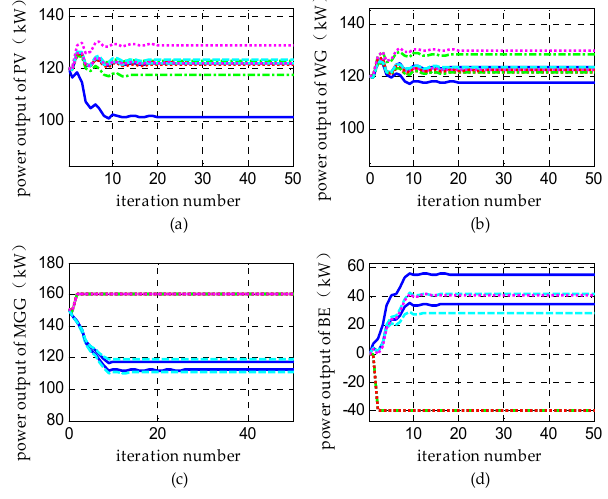
Figure 10. Dispatch results in Scenario D . ( a ) Power output of PV; ( b ) Power output of WG; ( c ) Power output of MGG; and ( d ) Power output of BE.